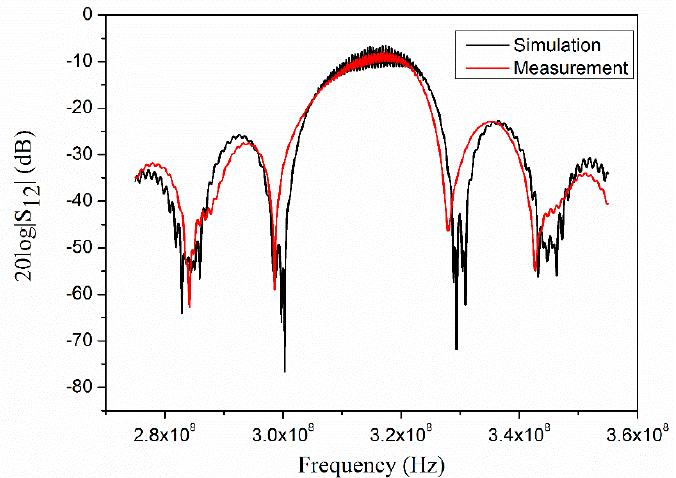
Figure 7. Simulated and measured S 12 characteristic of the test device.